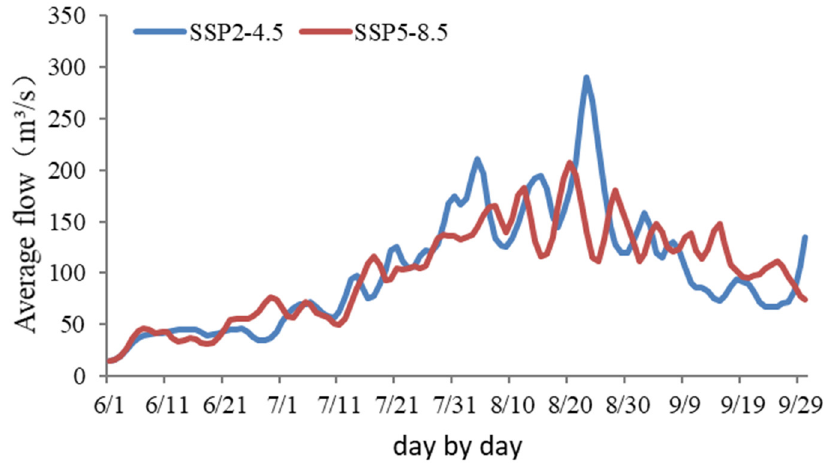
Figure 6. Changes in daily average runoff during the wet season under two climate scenarios from 2021 to 2050.